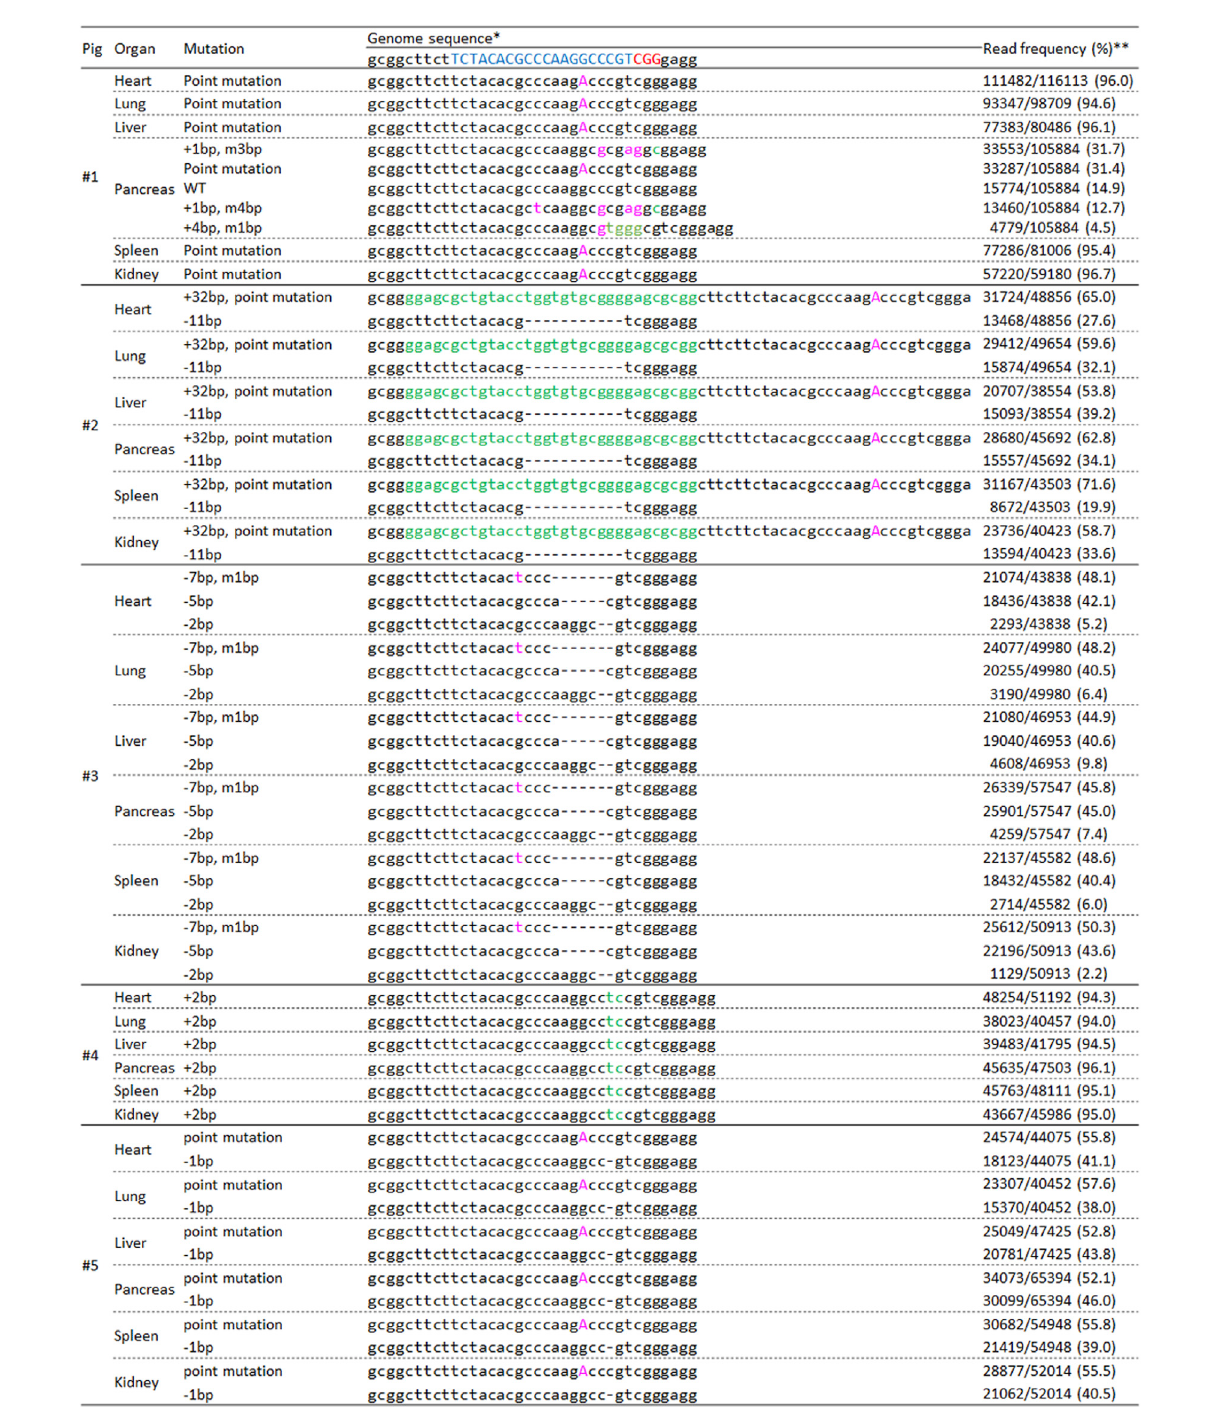
FIGURE 6 Deep-sequencing analysis of the INS target regions in major organs derived from delivered pigs. * The target and PAM sequences of gRNA are indicated in blue and red, respectively. Inserted and modi fi ed sequences are represented by green and pink, respectively. ** The frequency was calculated by dividing the number of amplicons by the total number of